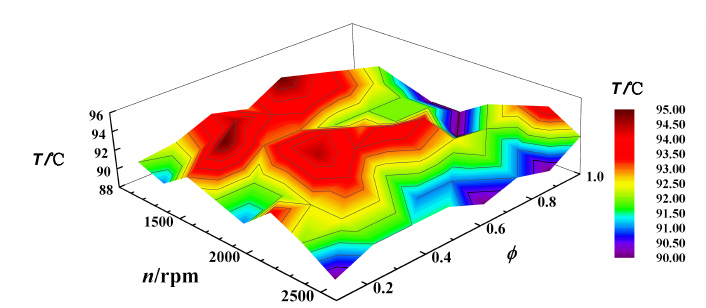
Figure 3. Map of target temperature of the water jacket in the DK32